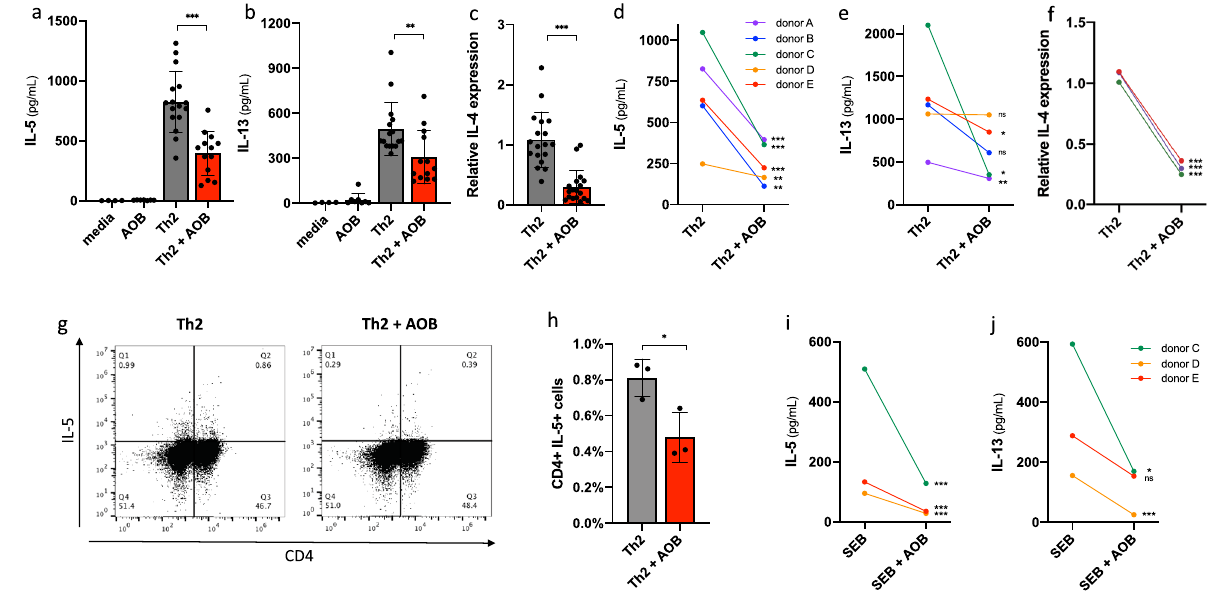
Figure 1. AOB inhibit Th2 immune polarization in human PBMC. ( a – f ) IL-5 and IL-13 supernatant levels are reduced with AOB pretreatment of PBMC prior to Th2 differentiation cocktail stimulation; measured by ELISA of supernatants 72 h post-stimulation. IL-4 gene expression is also reduced with AOB pretreatment; measured by qPCR 72 h post-stimulation. AOB pre-treatment prior to Th2 differentiation cocktail stimulation of PBMCs from donor A reduced the levels of IL-5 ( a ) and IL-13 ( b ) as well as IL-4 ( c ) gene expression (n ≥ 12, one-way ANOVA with multiple comparisons or unpaired t-test). ( d – f ) IL-5 ( d ), IL-13 ( e ), and IL-4 ( f ) levels/ expression are reduced in AOB-pretreated PBMC from 3 to 5 different donors (n ≥ 6 replicates per donor, shown on the figure is unpaired t-test p value for individual donors, unpaired t-test p value for aggregated donors: p < 0.0001 for IL-5, p < 0.01 for IL-13, p < 0.001 for IL-4). ( g , h ) The number of CD4+ IL-5+ cells is reduced with AOB pretreatment of PBMC following Th2 differentiation cocktail stimulation; measured by flow cytometry with anti-CD4 PerCP cy5.5 and anti-IL-5 PE antibodies applied 72 h post-stimulation. ( g ) Representative dot plot from donor C cells showing the reduction in CD4+ and IL-5+ cells. ( h ) The percentage of Th2 cells as CD4+ IL-5+ are reduced with AOB pretreatment (n = 3, donor C, unpaired t-test). IL-5 ( i ) and IL-13 ( j ) supernatant levels are reduced in the presence of AOB 7 days post-stimulation with SEB (1 µg/mL), measured by ELISA (n = 3 per donor, 3 donors, unpaired t-test, p < 0.0001 for IL-5 and IL-13 for aggregated donor data